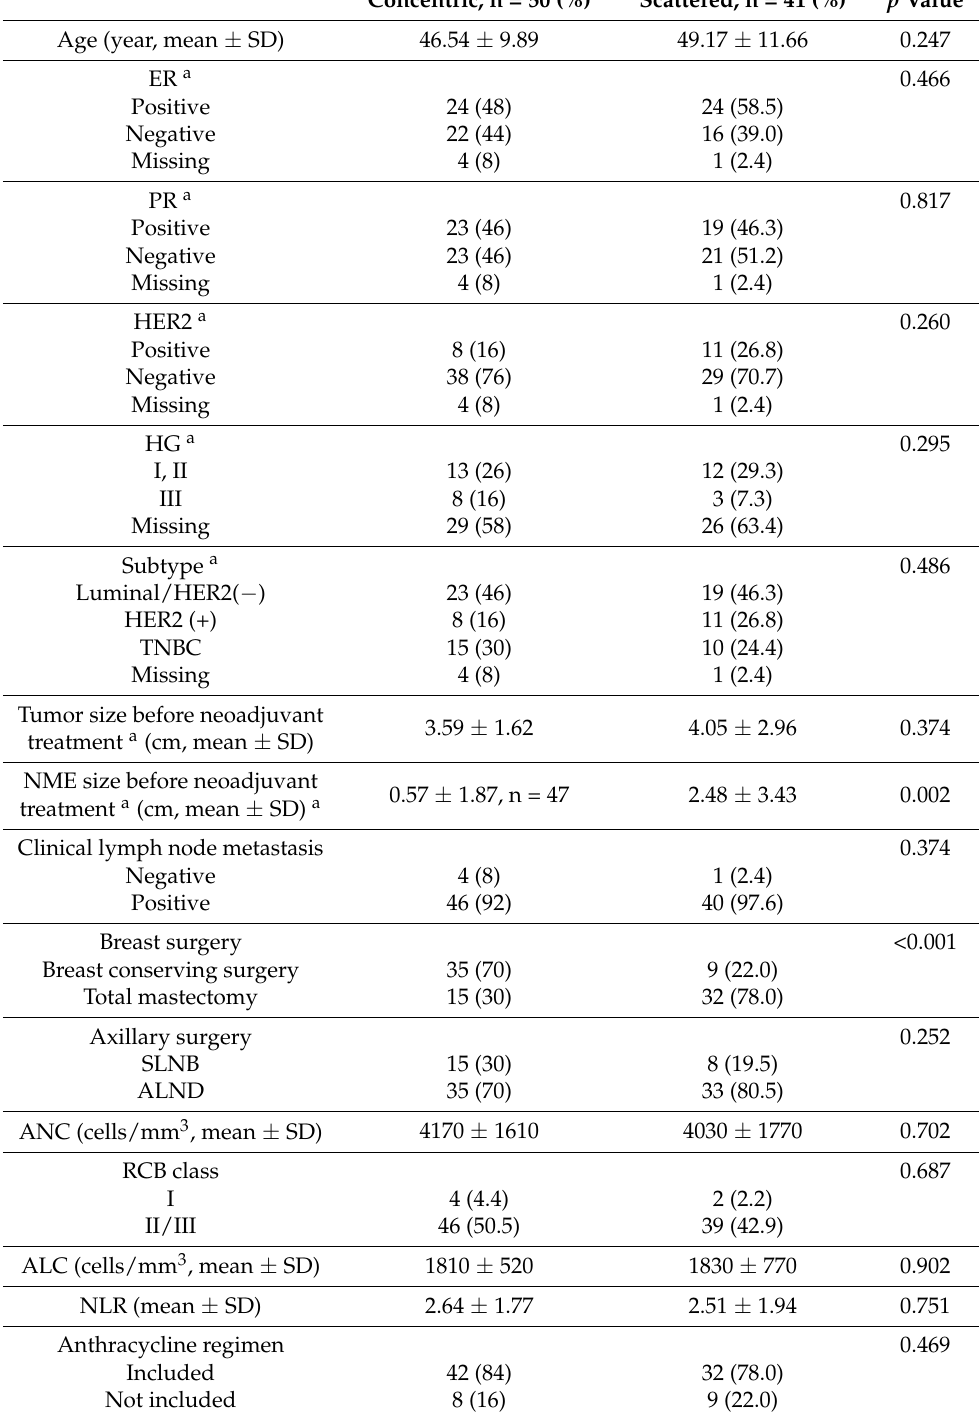
Table 1. Clinical characteristics in relation to tumor degradation